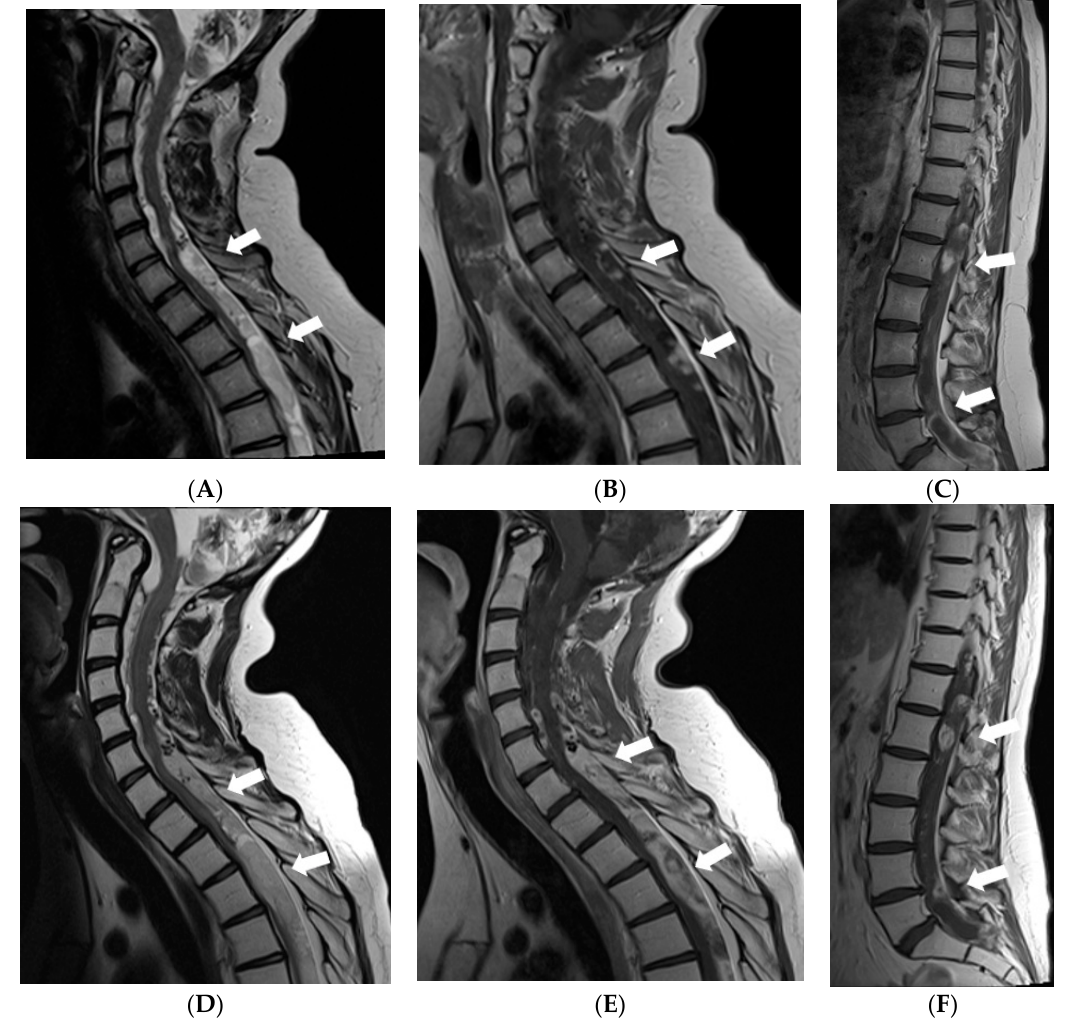
Figure 5. MRI of the spinal cord 6 years after the onset of symptoms: ( A , D ) Sagittal T2W, ( B , E ) T1W postcontrast images of the cervical and the upper thoracic spine, ( C , F ) postcontrast images of the middle/lower thoracic and the lumbar spine. In May 2017, ( A – C ) multiple confluent cystic extramedullary masses were found in the spinal canal through all its length, compressing the spinal cord at the level from C6 to T9 vertebrae. There was some nodular contrast-enhancement in the tumourous masses and diffuse meningeal enhancement. After radiotherapy in December 2017 follow-up MRI ( D – F ) demonstrated enlargement of the extramedullary masses in the lower cervical-upper thoracic spine with more vivid and diffuse enhancement, also, more vivid diffuse meningeal enhancement.